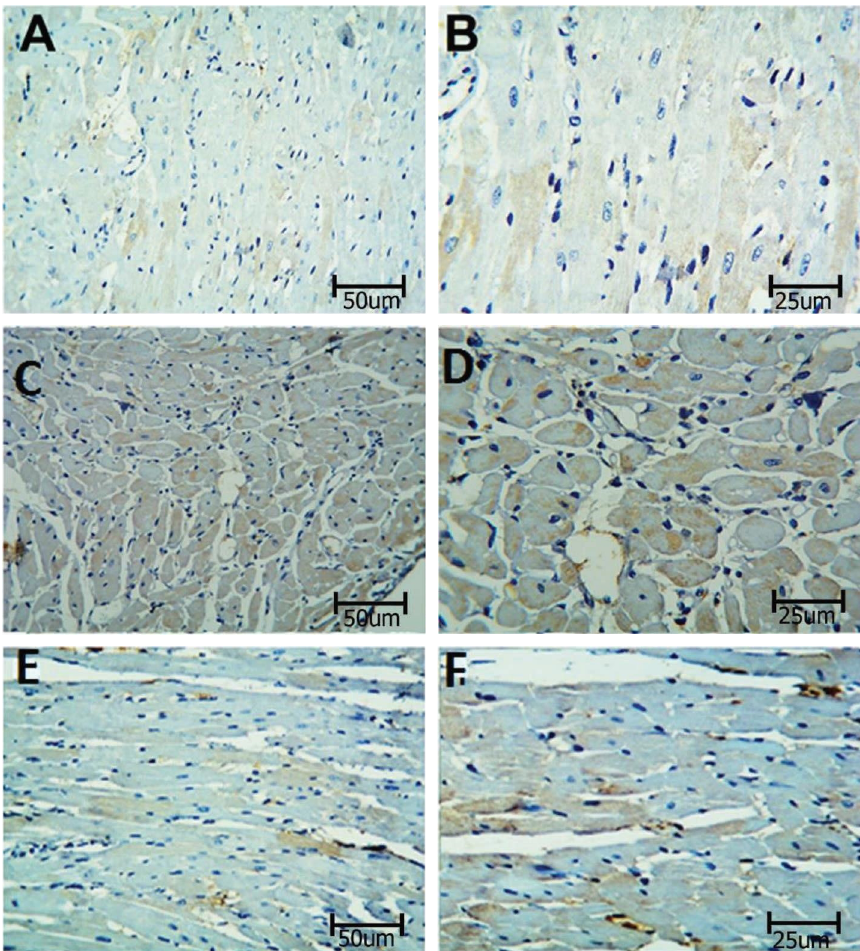
Figure 7: Histopathological section in the heart of rat stained with caspase-3 immune stain. a and b are the control group, c and d are the BPA group, and e and f are the BPA+LC group. Te cardiac muscle of the control group shows a minimal expression of the dye in the wall of the artery. Te expression of the color is notably increased in the BPA group and reduced in the BPA +LC group (caspase-3 immune stain; A, C, and E X 200, B, D, and F X 400).